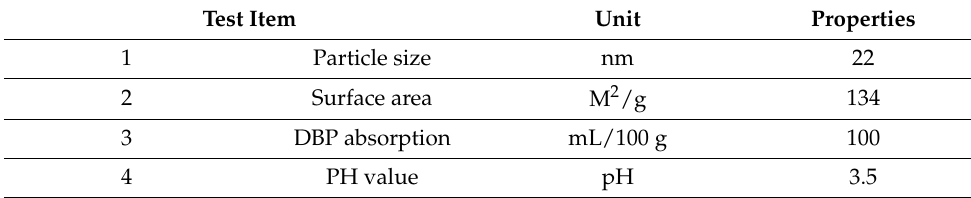
Table 4. Carbon black properties used in the study.